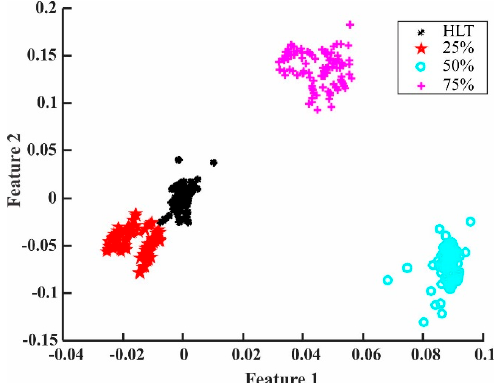
Figure 6. Projection of features, reduced by LDA, that characterize the condition of the gearbox onto the data set of infrared thermography.